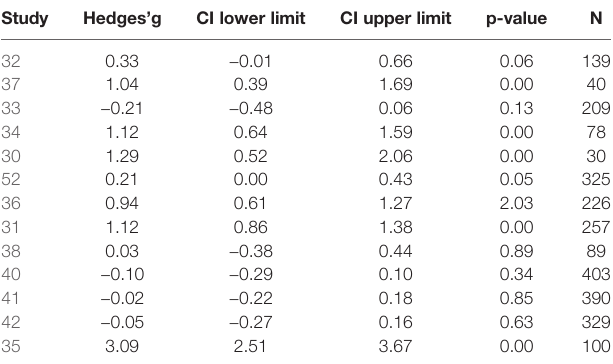
TABLE 6 | Combined outcomes of psychological and psychosocial interventions compared to control conditions. Study Hedges ’ g